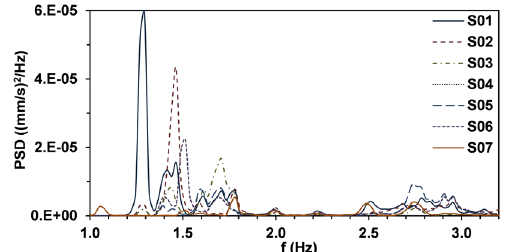
Figure 10. PSDs of S01-S07 in configuration C1.